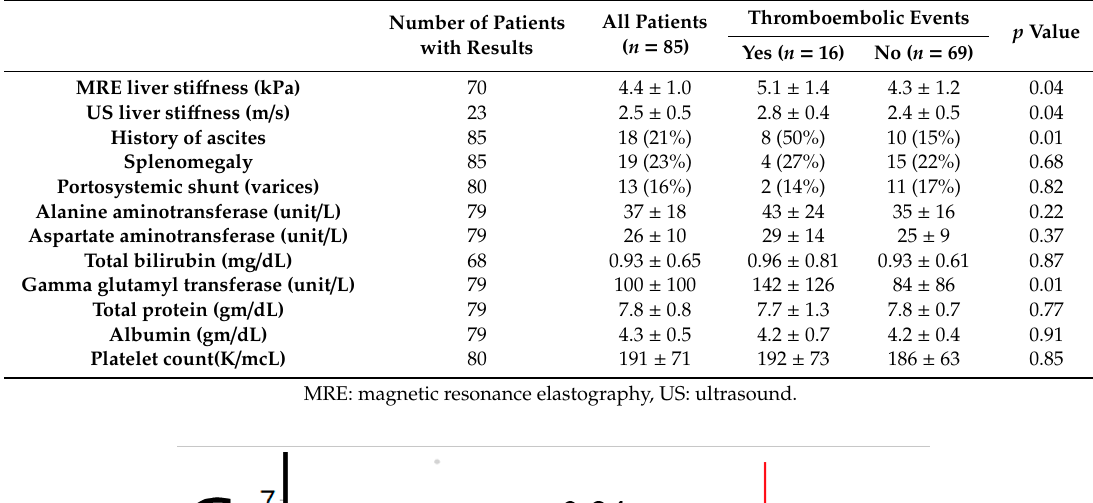
Table 3. Laboratory and liver imaging results in patients with and without thromboembolic events.